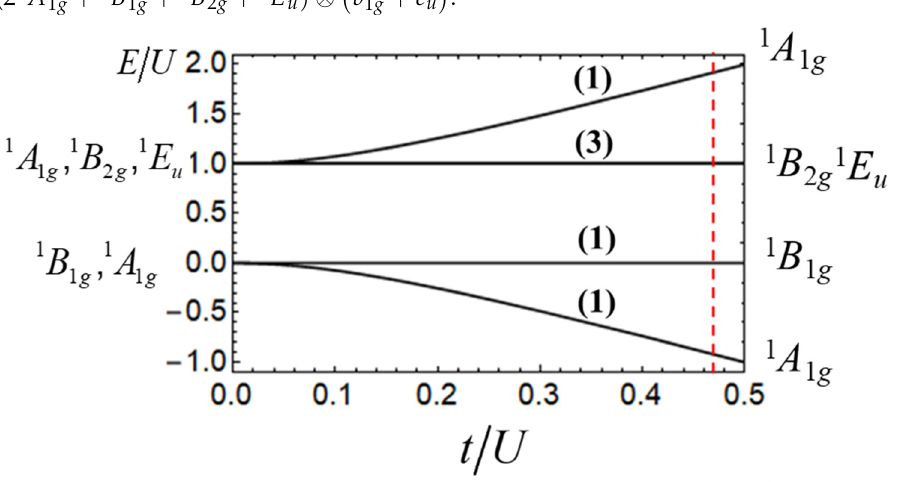
Figure 4. Electronic energy levels in the form E/U vs. t/U . The ratio t/U corresponding to the sample set of t and U values is shown by dashed red section. Numbers in the parentheses indicate multiplicities of the levels.